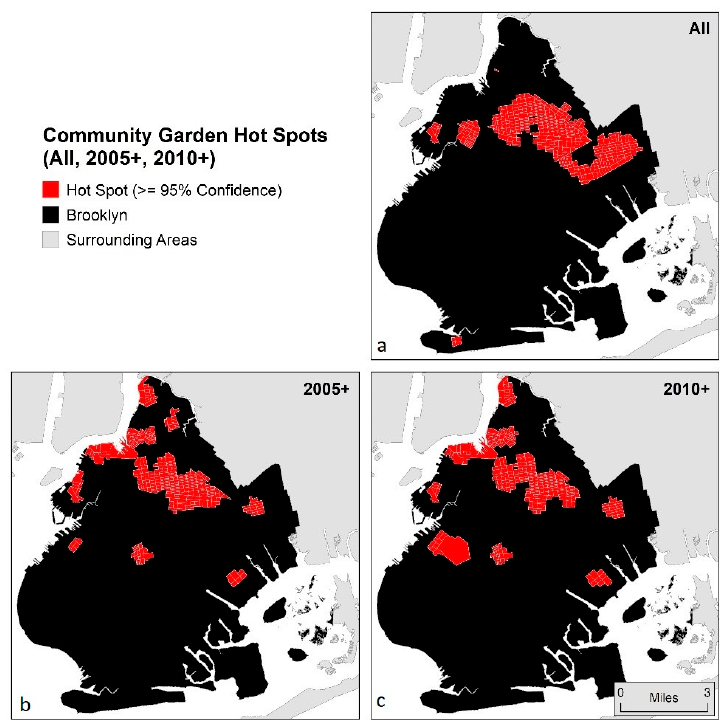
Figure 4. ( a ) Hot spots based on number of proximal community gardens founded any year;( b ) hot spots based on counts of number of proximal community gardens founded in 2005 or later; and ( c ) hot spots based on counts of number of proximal community gardens founded in 2010 or later. To accommodate error inherent in the five-year ACS estimates, only block groups that had a coefficient of variance (CV) of high (CV ≤ 12%) or medium reliability (CV = 13–40%) for both 2010 and 2015 were included in the analysis ( n = 1150) [67] (see Figure 5).